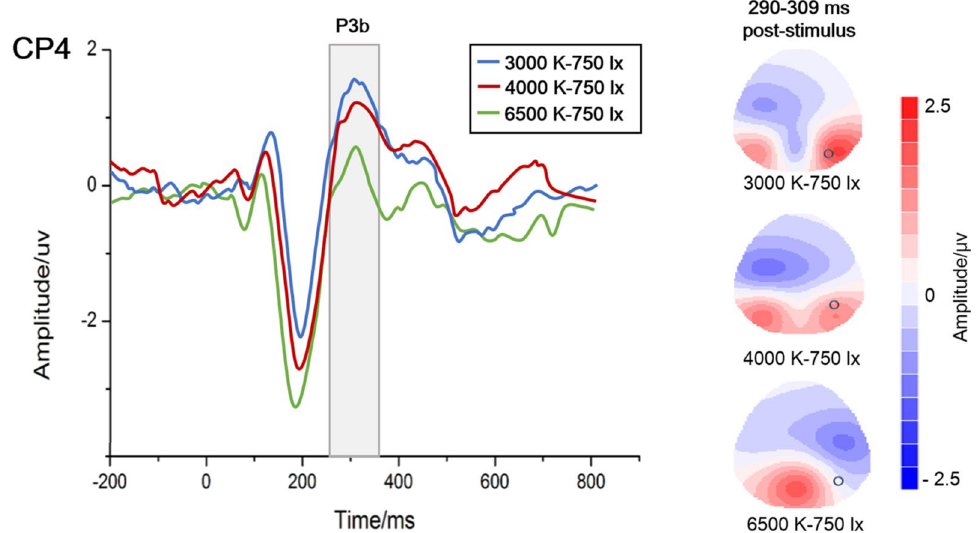
Figure 4. Grand average waveforms of P3b at the CP4 electrode and scalp topographic distributions with different colour temperatures (3000 K/4000 K/6500 K) under 750 lx illuminance. The shaded box shows a significant difference in P3b waves. And the circles at topographic maps represent the CP4 electrode when P3b occurred near 300